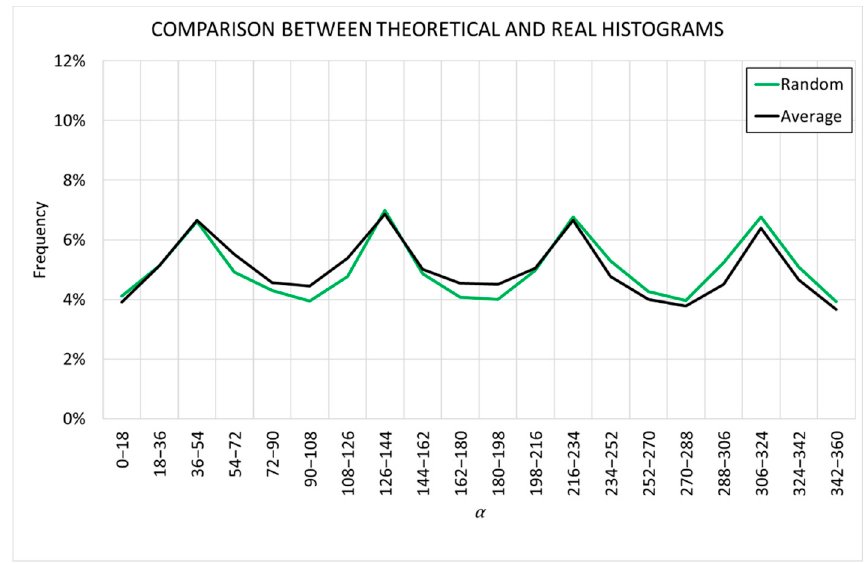
Figure 12. Radial test. Comparison between real and theoretical histograms.